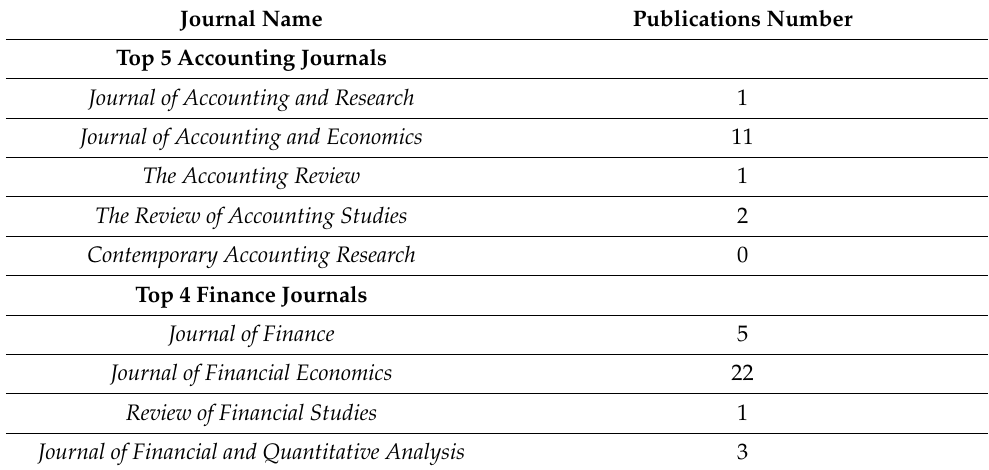
Table 1. Publications in Leading Finance and Accounting Journals and Journals